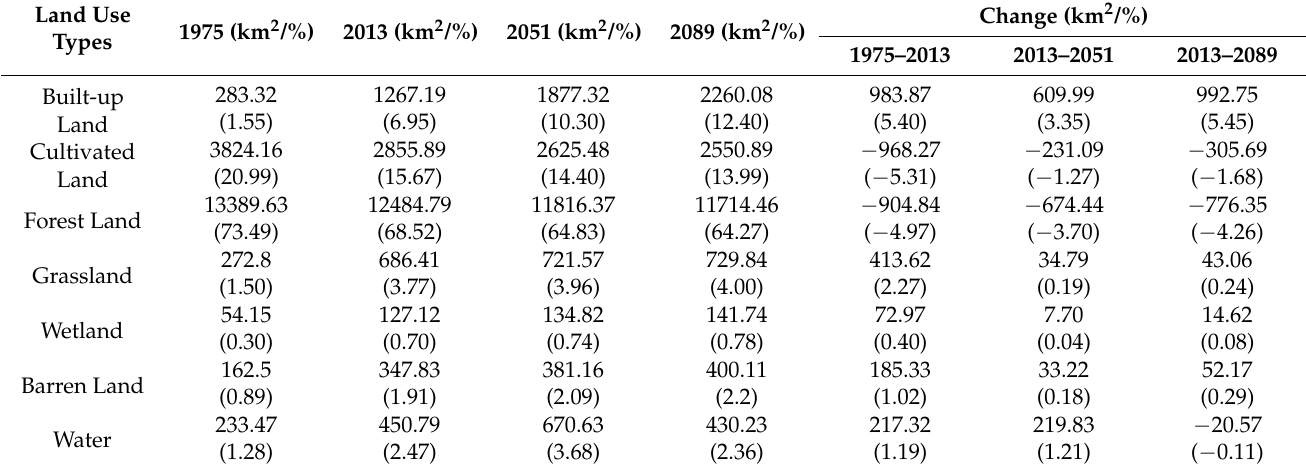
Table 6. Area and percent for each land use type during the years 1975, 2013, 2051, and